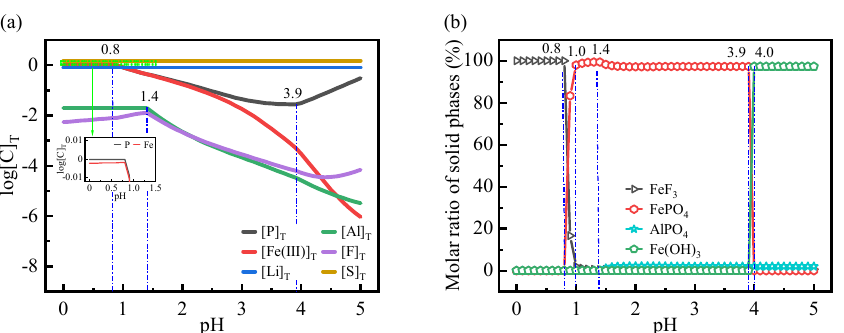
Figure 3. ( a ) Elements equilibrium total concentration and ( b ) solid phases distribution of the Li + –Fe 3+ –Al 3+ –PO 43 − –SO 42 − –F − –H 2 O system (298 K, [P] O = [Fe(III)] O = 1 M, [Li] O = 0.8 M, [S] O = 1.5 M, [Al] O = [F] O = 0.02 M).